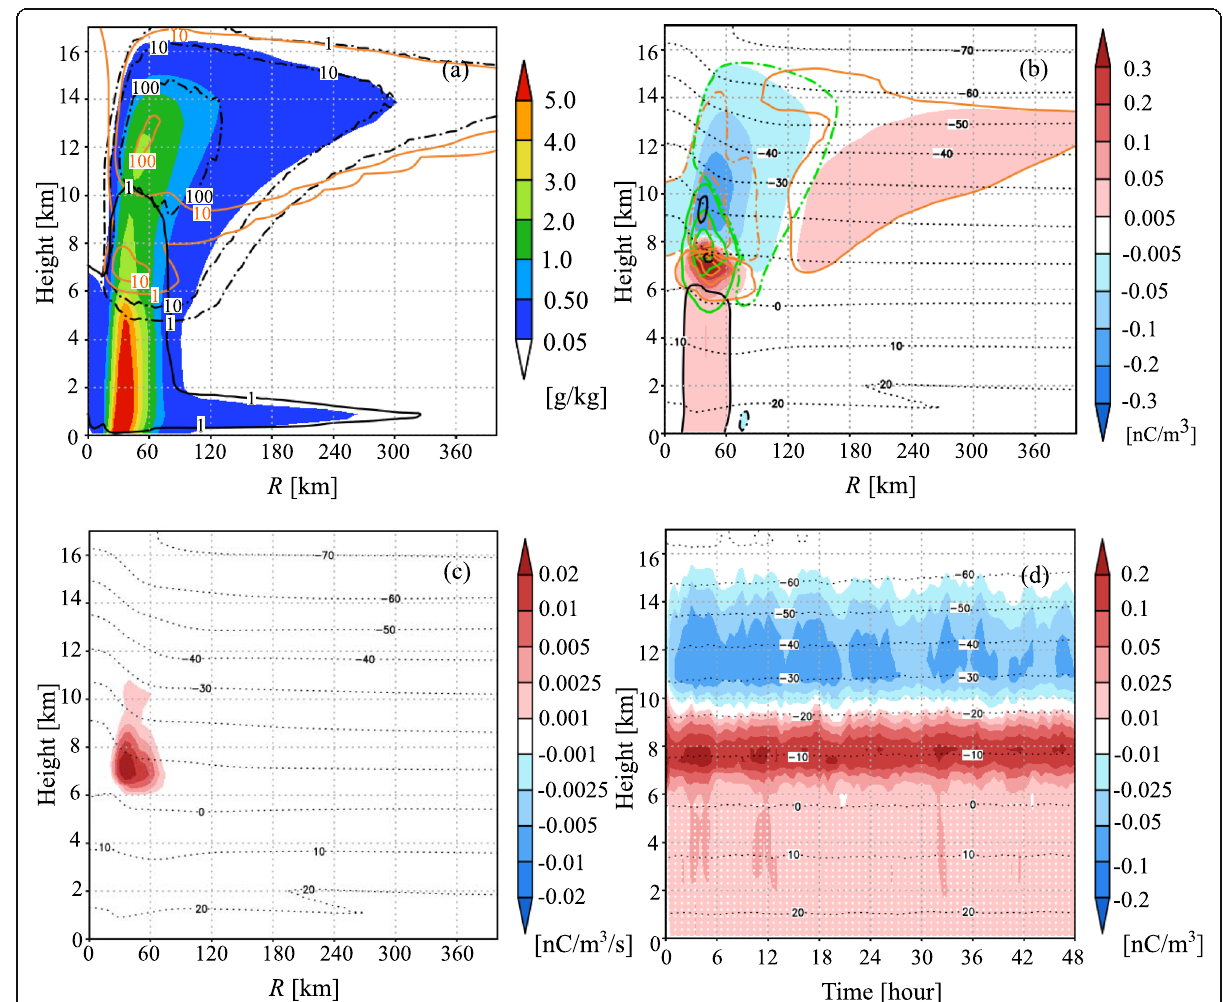
Fig. 7 a Number concentrations of water (black solid contour line; unit: cm − 3 ), ice and snow (orange contour line; unit: L − 1 ), and graupel (black dot-dashed line; unit: L − 1 ), and q hyd (shaded area). b Charge density of hydrometeors (shaded area), cloud and rain (black contour line), ice and snow (orange contour line), and graupel (green contour line). c Charge density rate added to graupel by non-inductive charge separation over the z – R plane simulated and d temporal evolution of the charge density of graupel tangentially averaged over 20 km < R < 80 km with N 0 = 10 cm − 3 . The white dotted area in d indicated the charge density of raindrops. The dotted line in b – d indicates temperature (°C). Solid and dash- dotted contours in b show positive and negative charge charge densities, respectively. The contour lines in b show 0.01, 0.1, and 0.3 nC m − 3 , respectively. The variables were tangentially averaged during the last 12 h of the